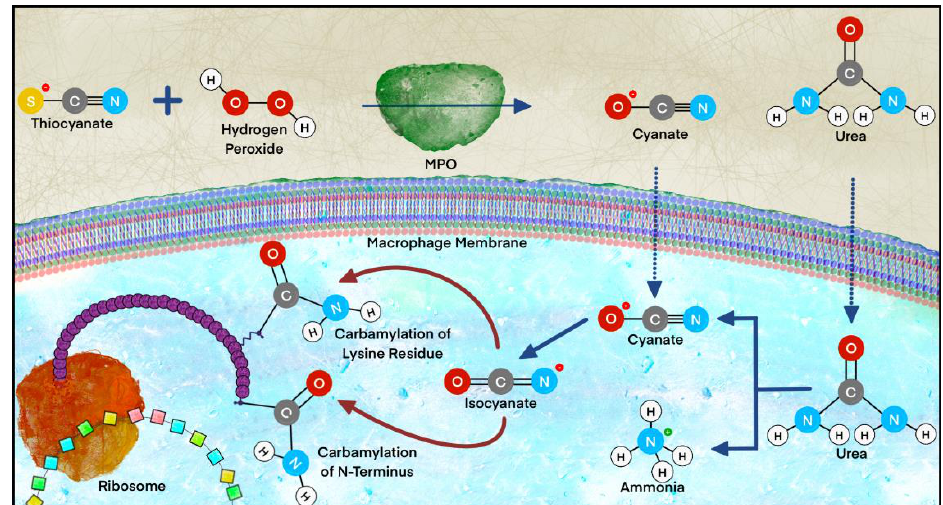
Figure 2. Process of carbamylation. Carbamylation occurs through two primary pathways that converge due to the spontaneous reactivity of isocyanate with lysine residues and the N-termini of nascent polypeptides. The first and predominant pathway is the spontaneous dissociation of urea to cyanate and ammonia. The second pathway is the conversion of thiocyanate and hydrogen peroxide to cyanate under the action of myeloperoxidase. Once cyanate is formed, it is converted into isocyanate, and the spontaneous and irreversible process of carbamylation commences. MPO, myeloperoxidase.